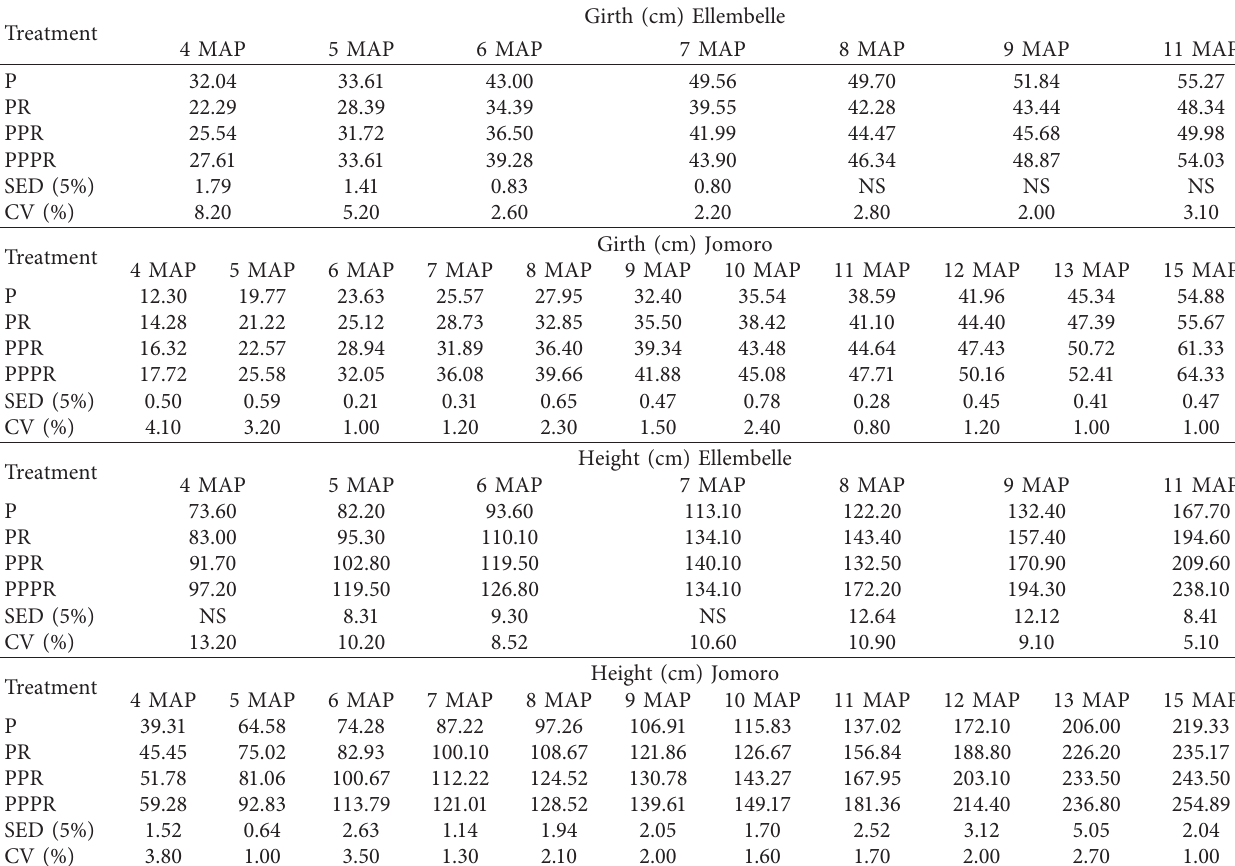
Table 4: Stem girth and height of plantain at Ellembelle and Jomoro sites.